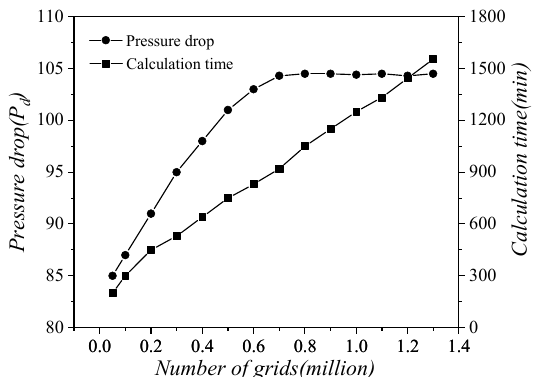
Figure 3. Independence of the number of grids.